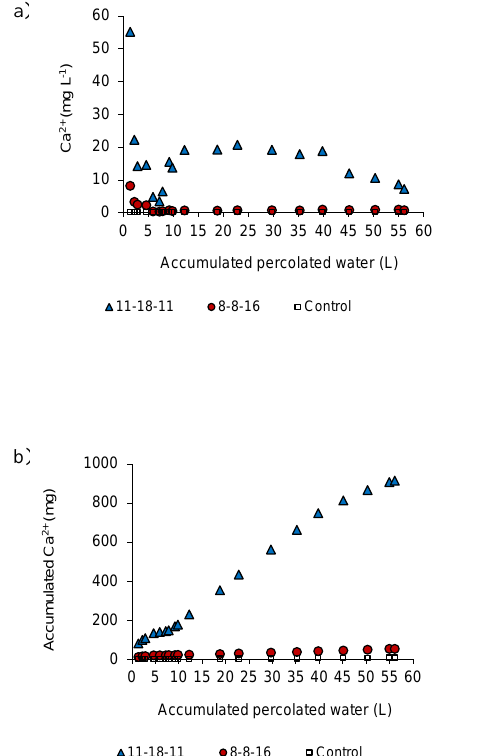
Figure 7. Calcium concentrations in leachates (a) and accumulated Ca 2+ losses (b) from fertilized and control columns along the experiment (average of three replicates).